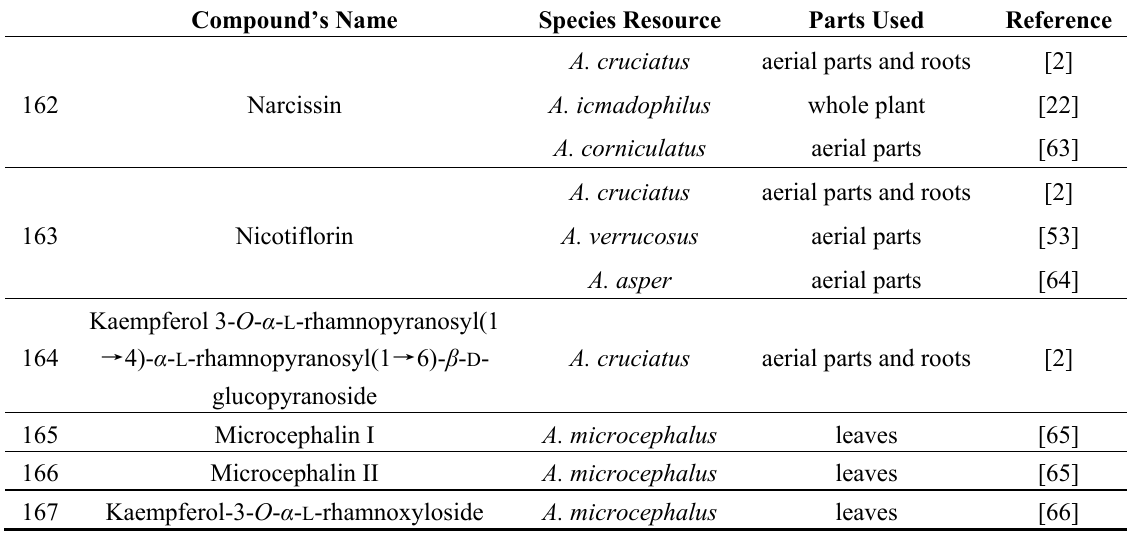
Table 3. Flavonoids from the Astragalus genus ( 162 – 224